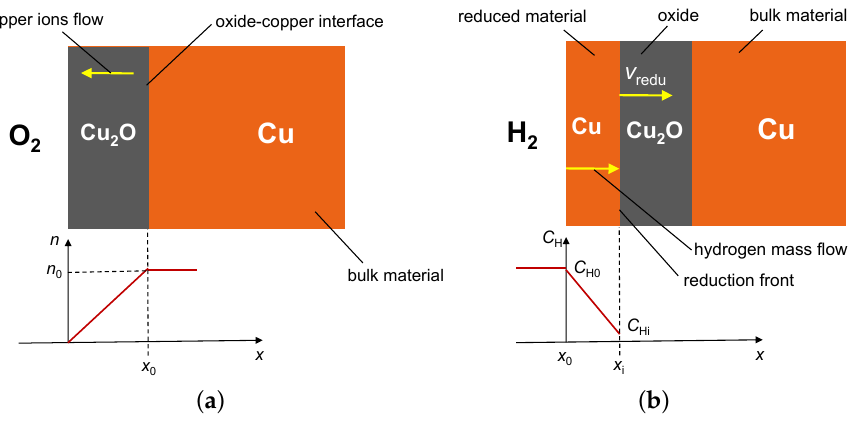
Figure A1. Simplified mechanisms of ( a ) oxidation of copper and ( b ) reduction of cuprous